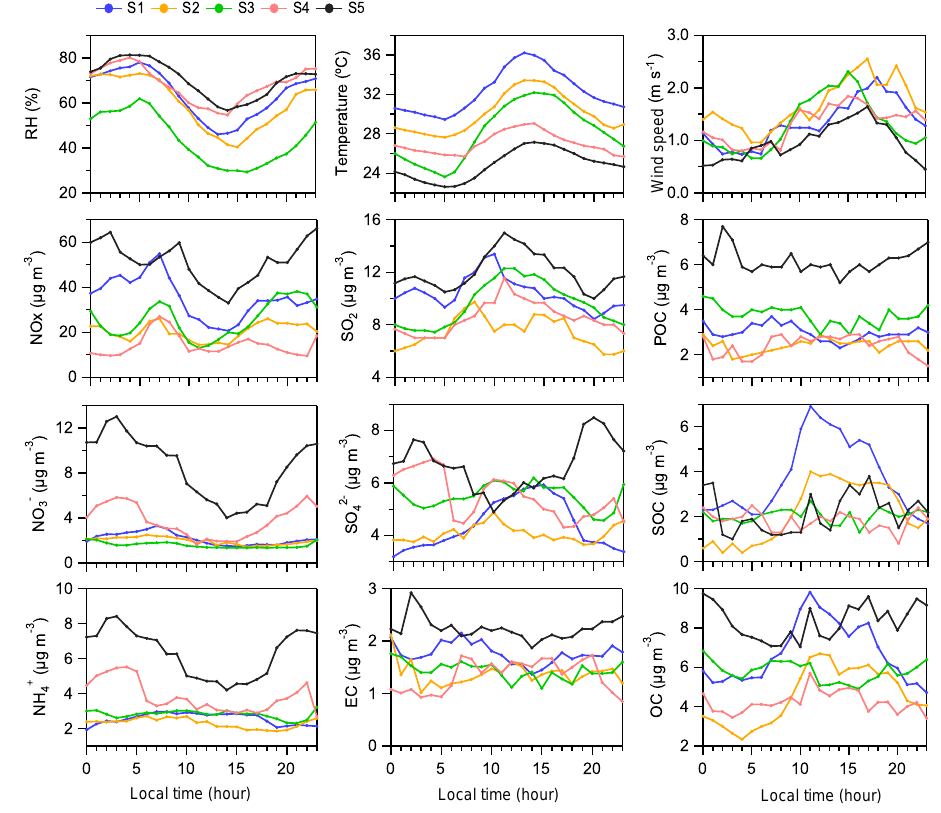
Figure 3. Diurnal profiles of PM 2 . 5 species, gaseous pollutants, and meteorological variables during the five stages.